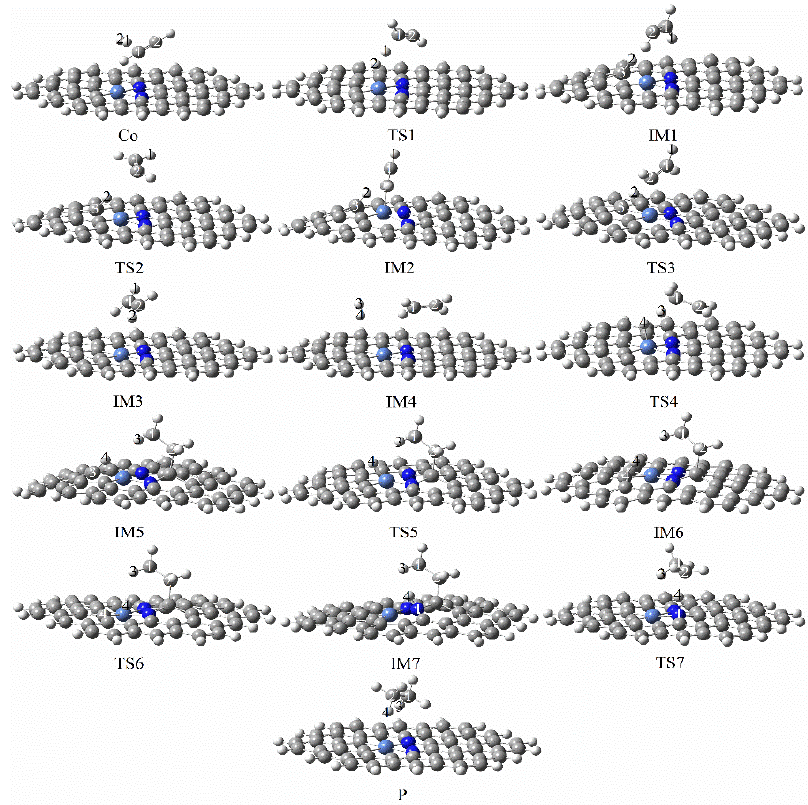
Figure 7. Optimal reaction pathway for acetylene hydrogenation catalyzed by graphene-NiN 2 catalyst. (A)